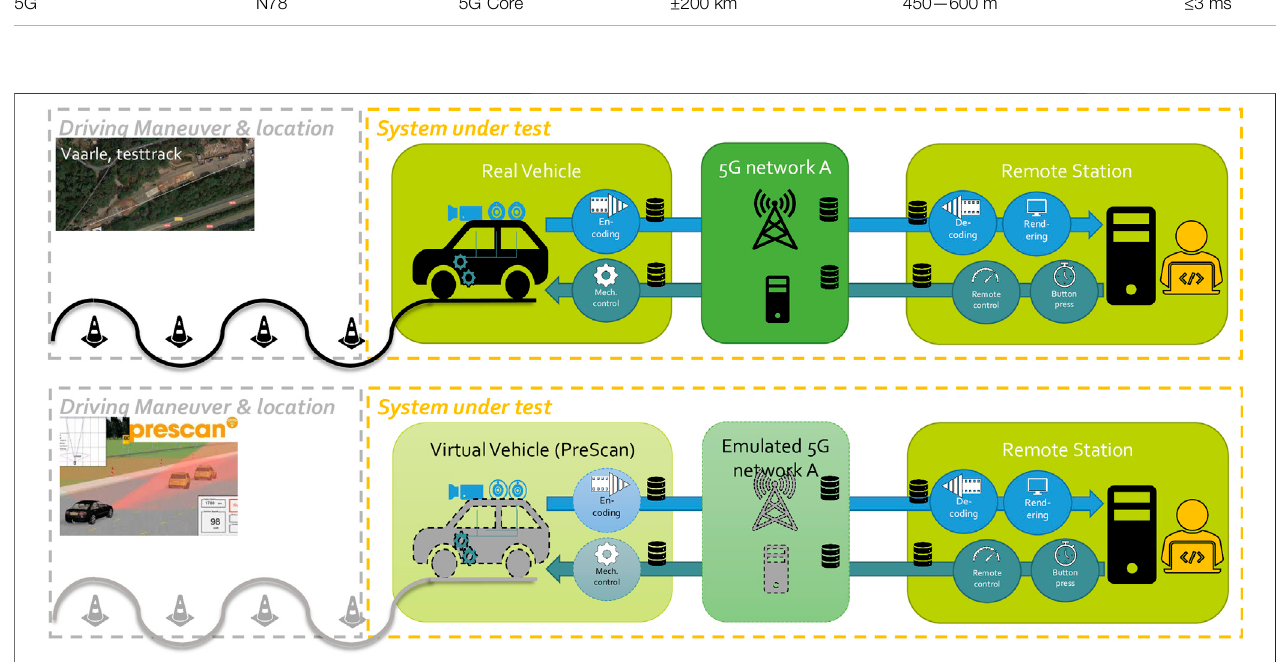
FIGURE5| Systemundertestforpositionaccuracy/relativereactiontime(top:realremotedriverwithrealremotestationcontrollingarealvehicleontesttrackover arealdeployment5Gnetworkvs.bottom:Hardware-in-the-Loop(virtual),witharealremotestationandremotedriver,butanemulatedvirtualnetworkandvirtualvehicle (in PreScan)) test (only showing slalom in this fi gure; straight-line braking was in virtual setup as well).